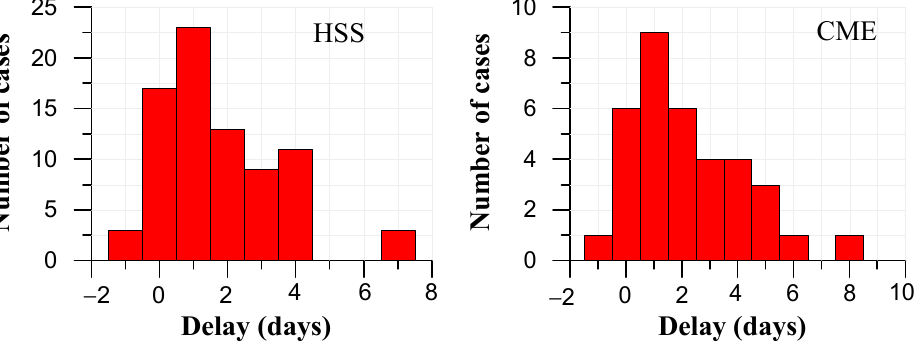
Figure 9. The number of thunderstorms after the arrival of geoeffective coronal mass ejections and high-speed solar wind streams to the Earth.